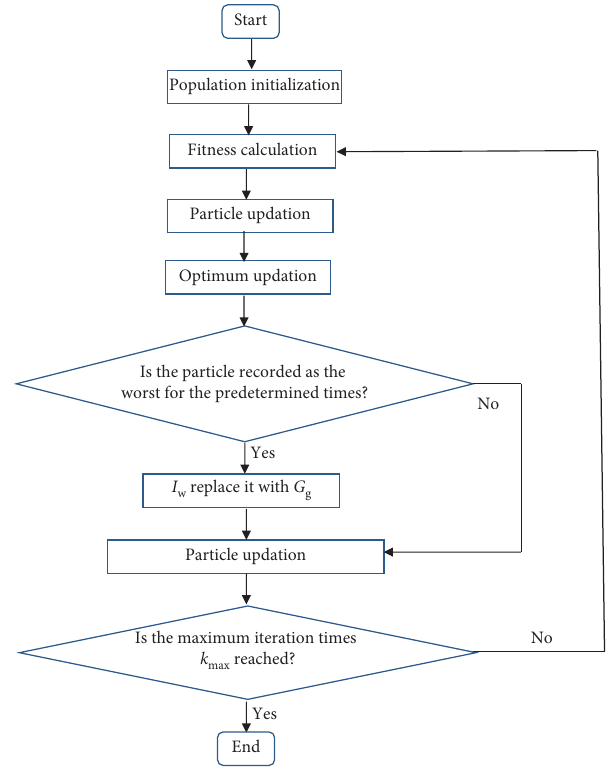
Figure 2: The flowchart of the IMPSCO